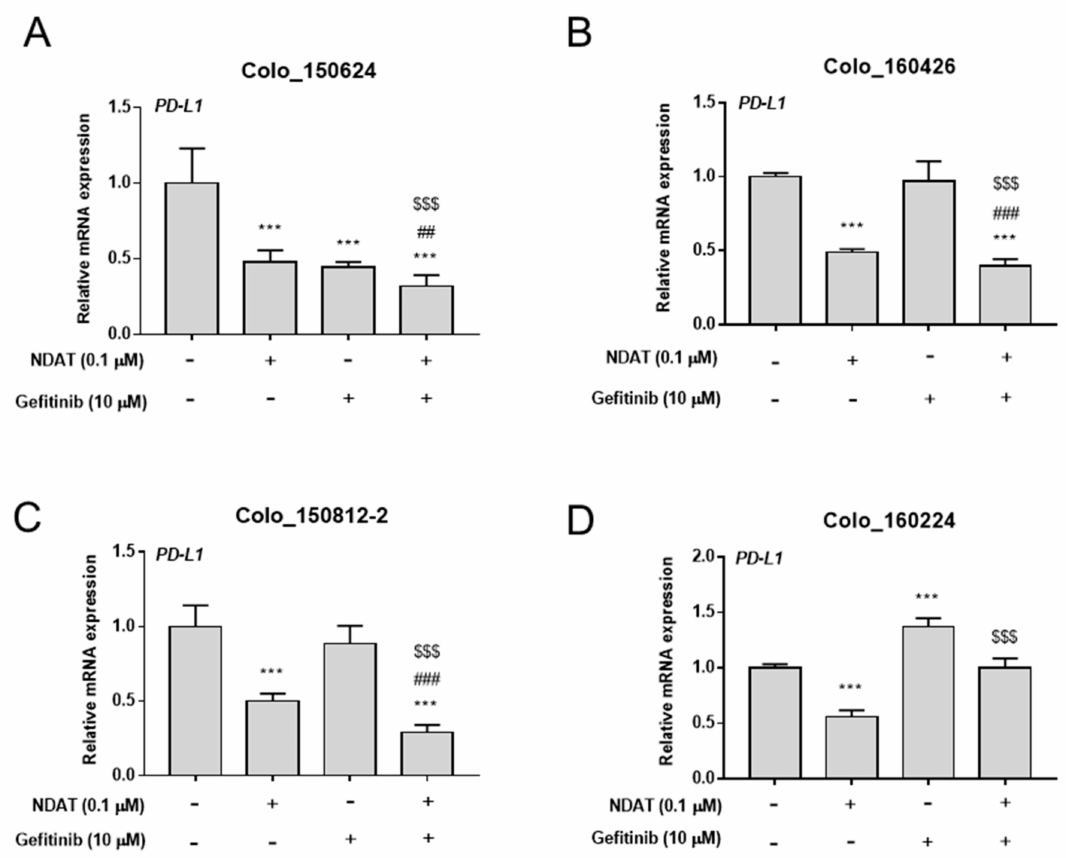
Figure 2. NDAT attenuate expression of PD-L1 regulated by gefitinib in human CRC primary cell cultures. Four established primary human CRC cell cultures, Colo_150624 ( A ), Colo_160426 ( B ), Colo_150812-2 ( C ), and Colo_160224 ( D ), were seeded in six-well plates and treated with di ff erent concentrations of gefitinib (10 µ M), NDAT (0.1 µ M), or their combination after starvation for 24 h. Cells were harvested and total RNA was extracted. qPCR was conducted for PD-L1 expression. N = 6. Data are expressed as mean ± SD; *** p < 0.001, compared with untreated control; ### p < 0.001, compared with NDAT; $$$ p < 0.001, compared with